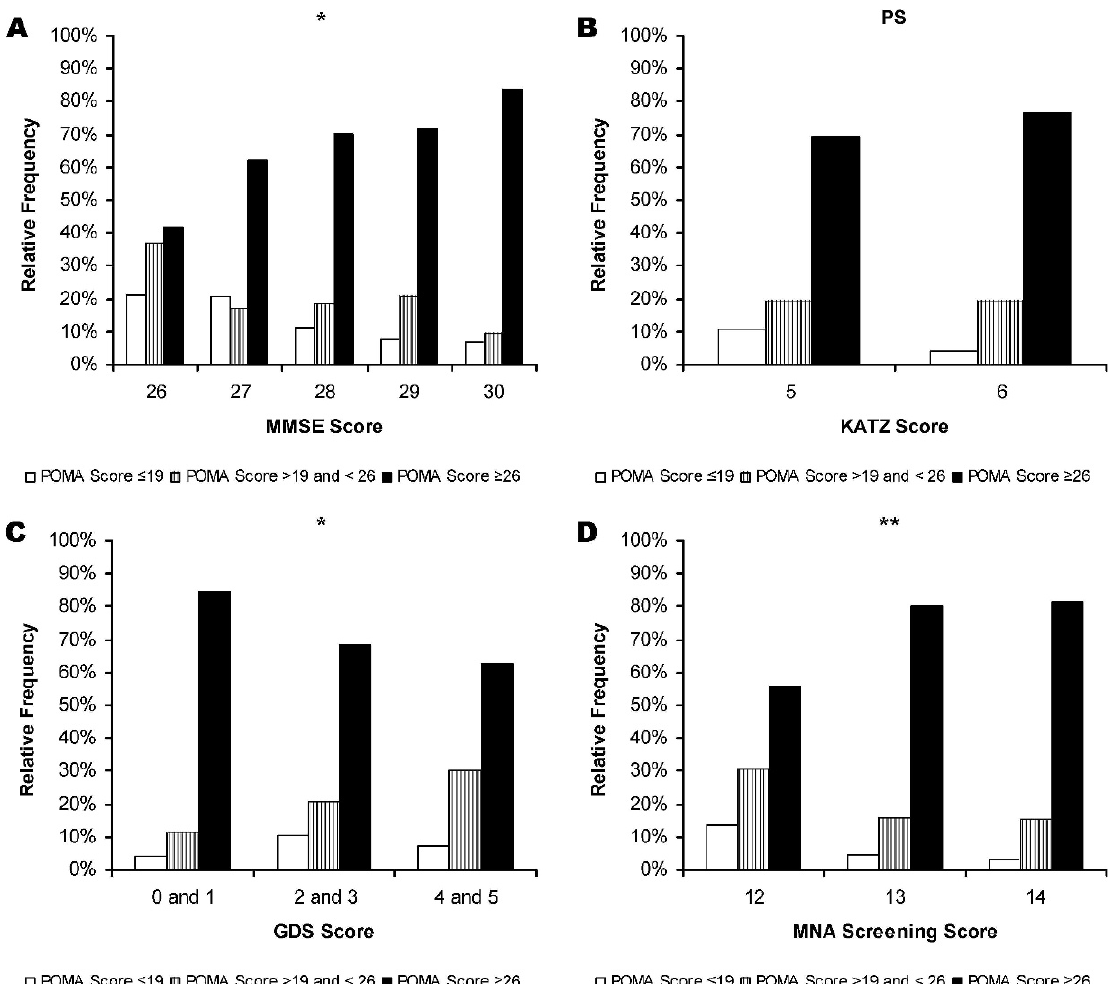
Figure 5 - Graphs depicting the relative frequency of individuals in a given POMA score range per MMSE (A), Katz (B), GDS (C) and MNA (D) normal score range. AS: 0.10 . p $ 0.05; * p , 0.05; ** p